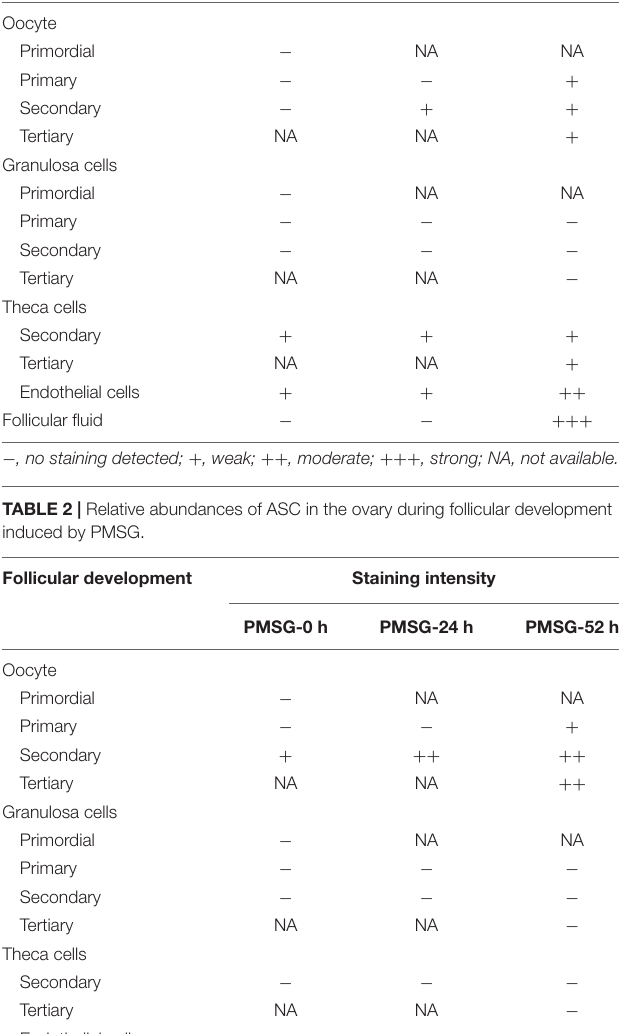
value represents the mean ± SE. One-way analysis of variance (ANOVA) was